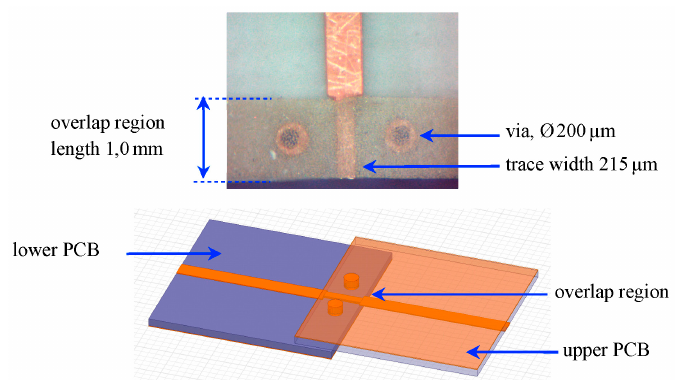
Figure 3. Planar transmission line contacts connected with ACP (Adapted with permission from [6], IEEE, 2017).